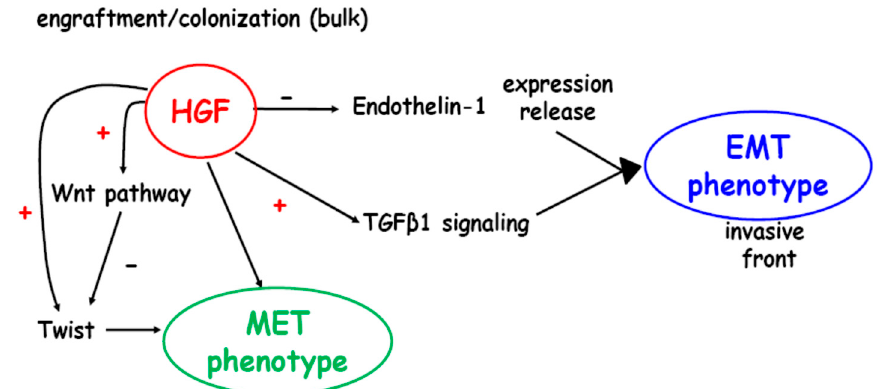
Figure 7. Bone metastases from breast carcinoma show a different phenotype at the invasive front (epithelial-mesenchymal transition, EMT) and in the bulk (mesenchymal-epithelial transition, MET), and the underlying molecular profiles regulated by HGF and TGF β 1 are schematized. ( − ) Pathway inhibition; ( + ) pathway activation.